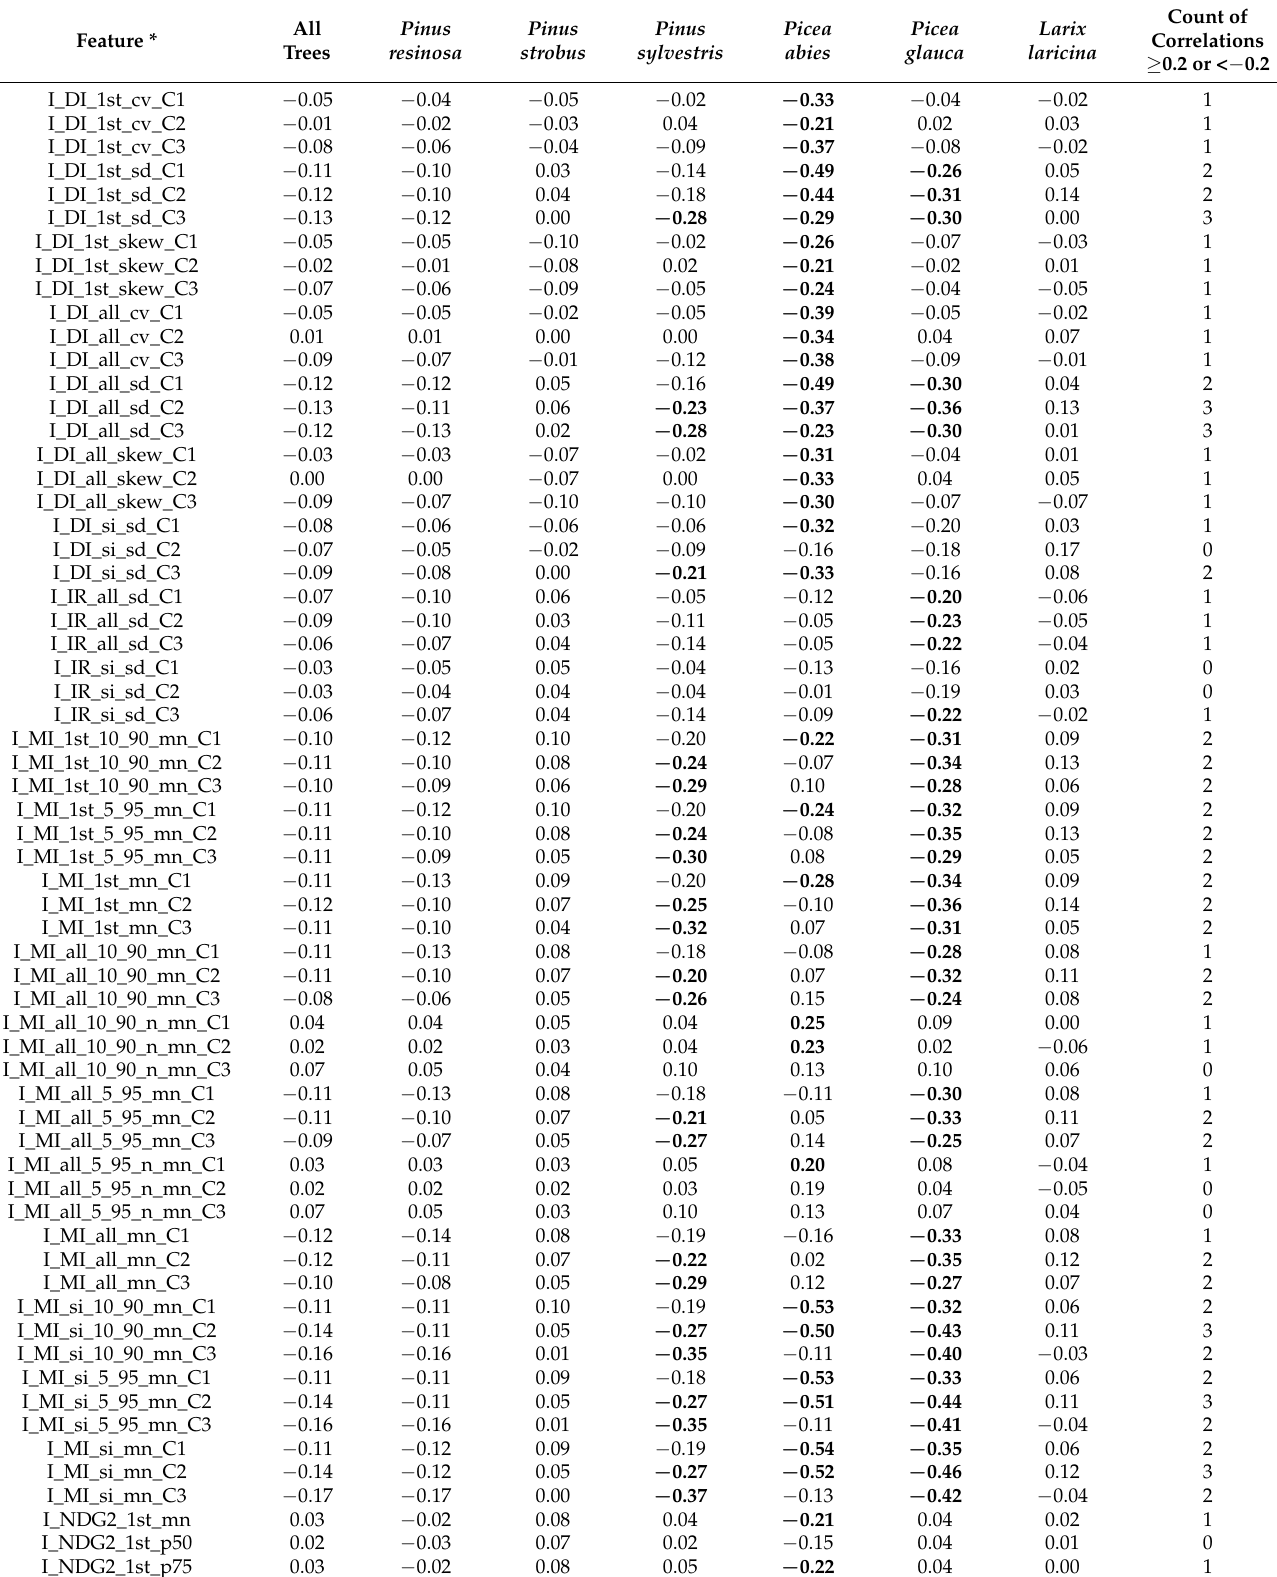
Table A2. Correlations between raw intensity features and mean scan